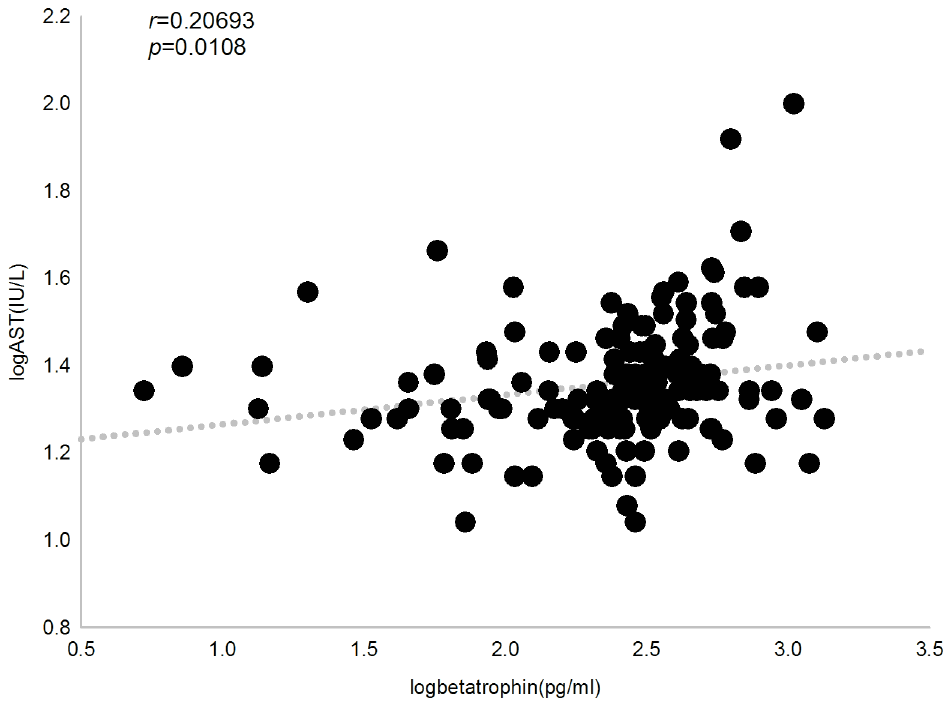
Fig 6. Correlation between plasma betatrophin concentration and aspartate transaminase level. Betatrophinlevel positively correlates with aspartate transaminaselevel in all subjects ( r = 0.207, P =